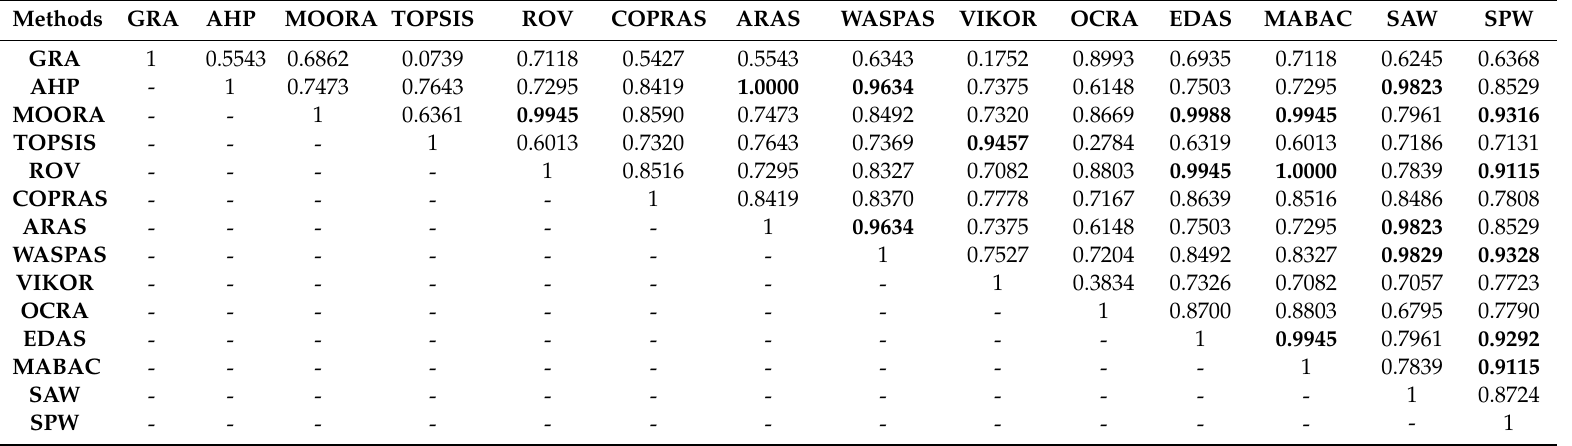
Table 8. Spearman’s rank correlation coe ffi cients of the applied MCDM